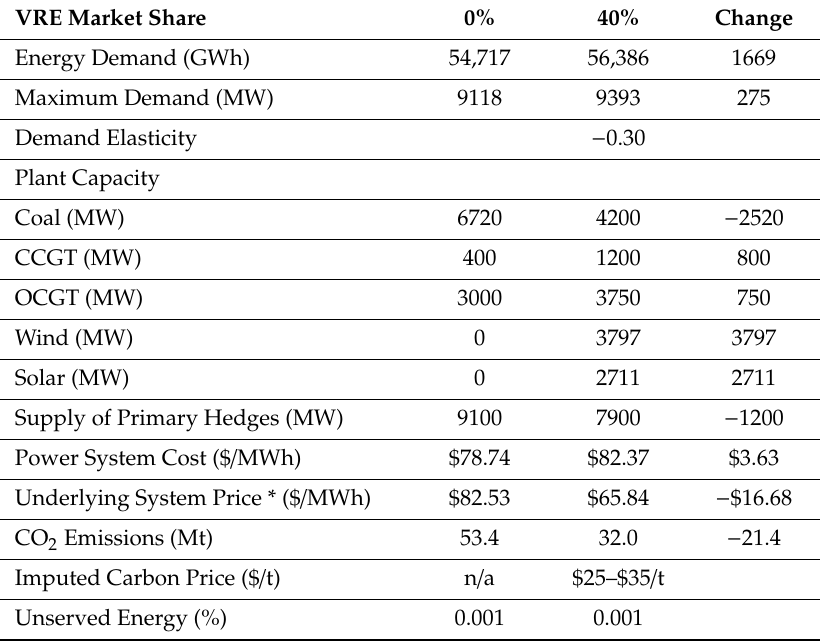
Table 2. Overview of key model